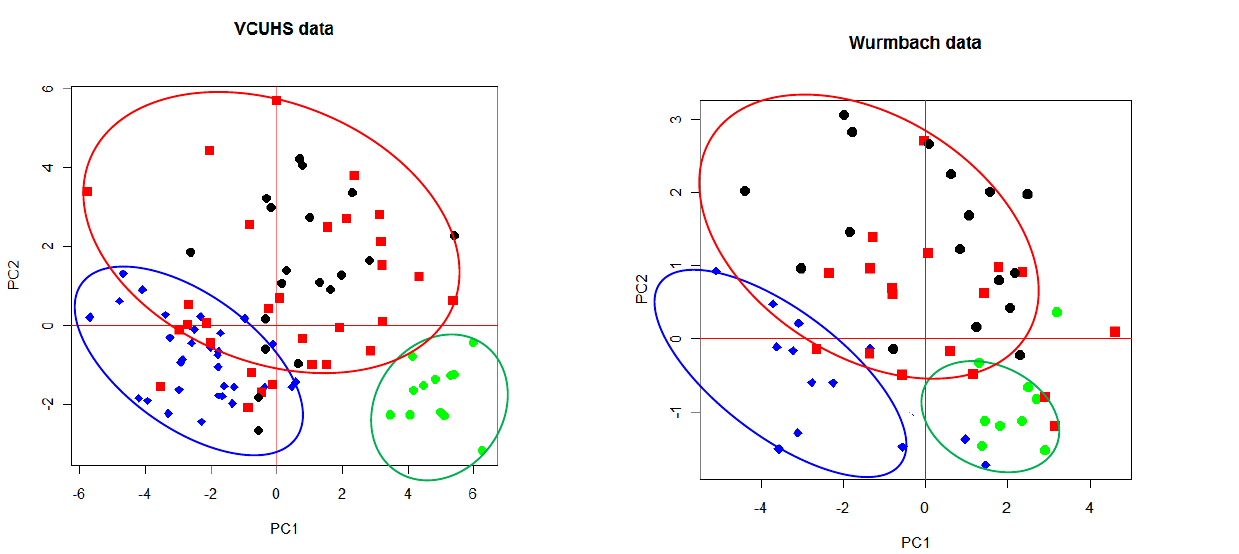
Green = normal control livers; Blue = cirrhosis; Red = early stage HCC; Black = late stage HCC. Normal tissues cluster well away from either cirrhosis or tumors. Both the